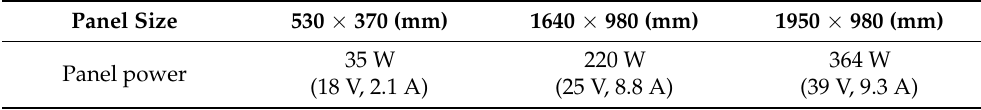
Table 2. Photovoltaic (PV) panel output and